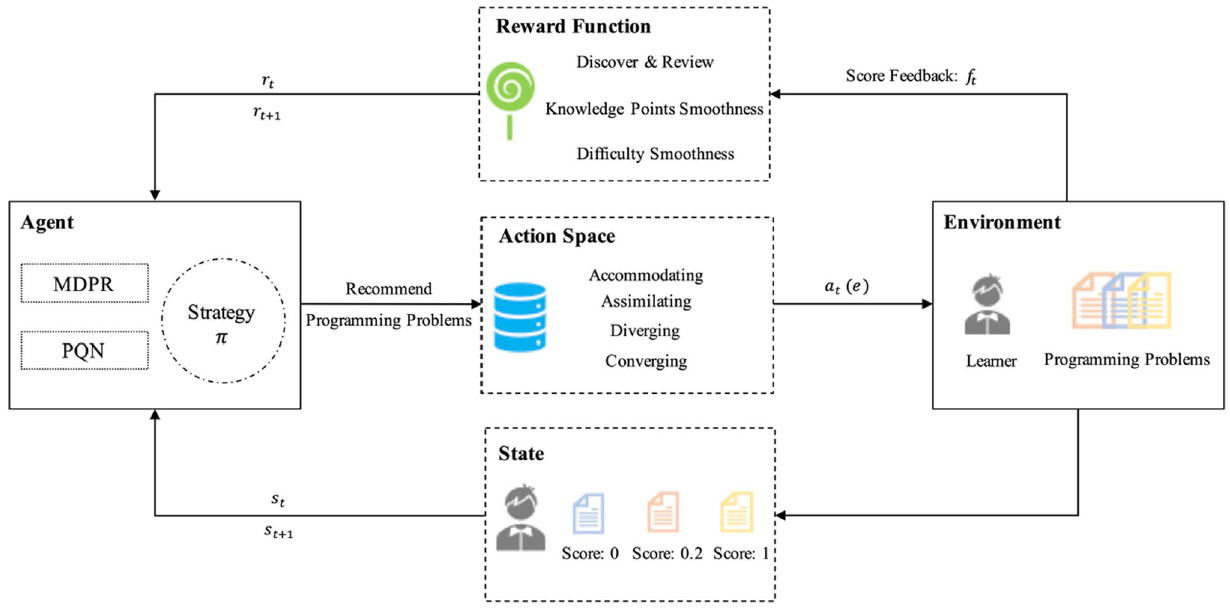
Fig. 4 DRLP: the framework of programming problem recommendation based on deep reinforcement